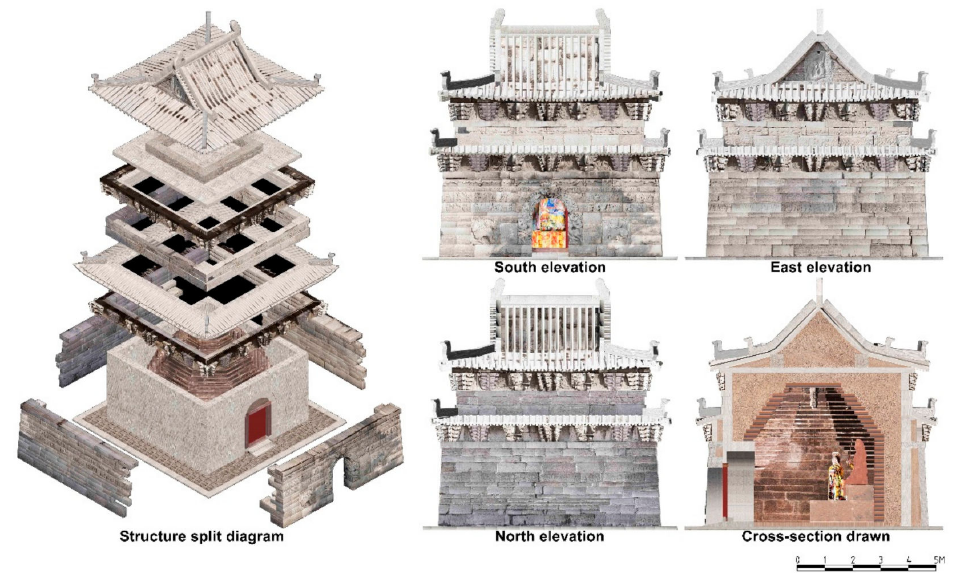
Figure 18. Separable model, elevation diagram, and section diagram of the Limestone Hall obtained by recovery (ideal